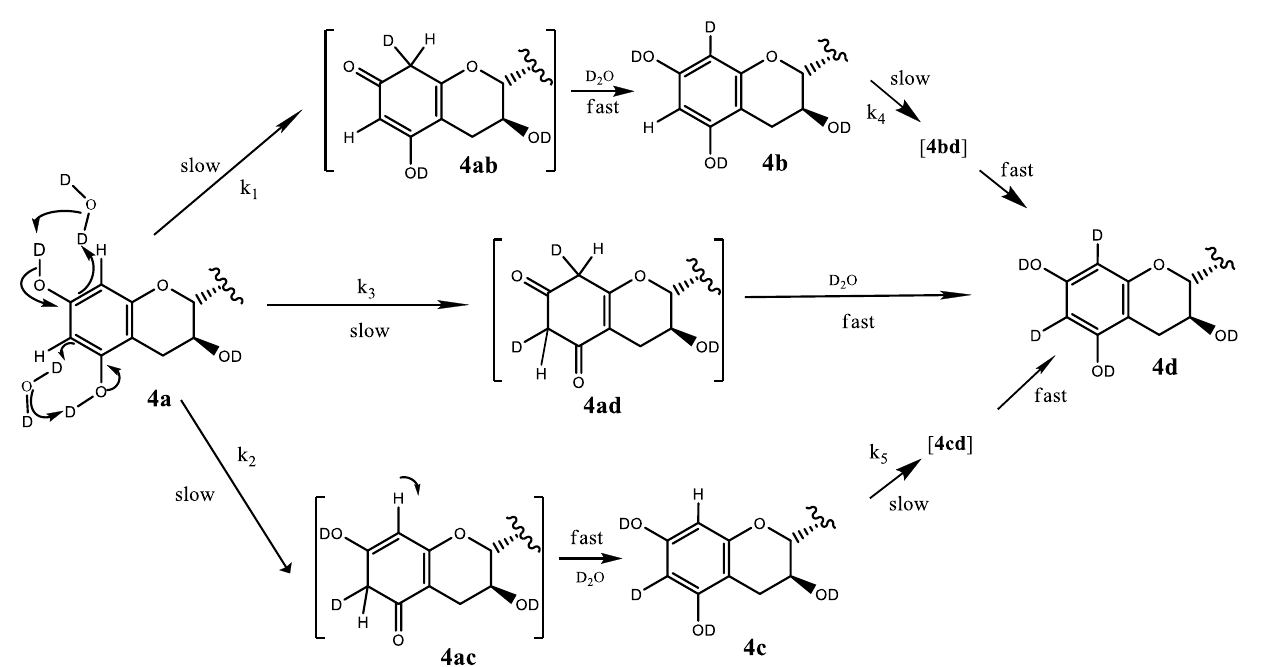
Scheme 4. Proposed reaction mechanism for H/D exchange at C(6) and C(8) in the catechin/D 2 O reacting system.